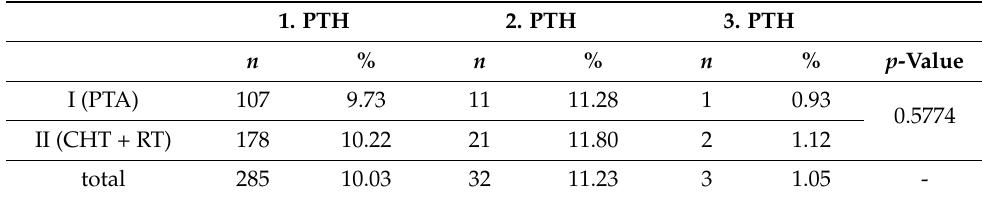
Table 6. Repeated postoperative bleeding in the two groups.